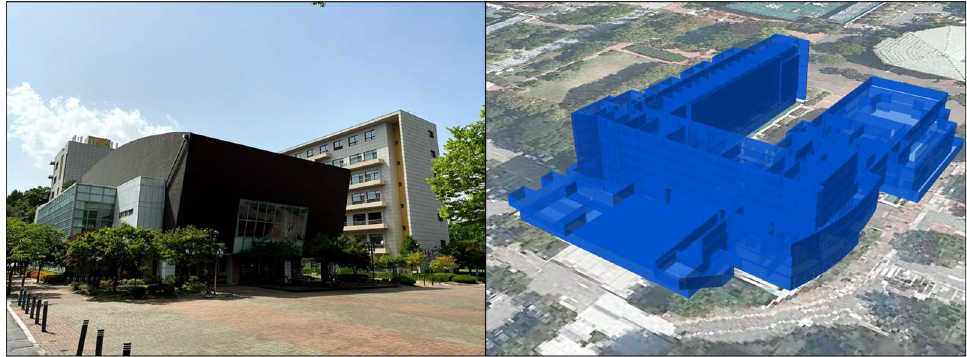
Figure 10. The study area of the experimental implementation.